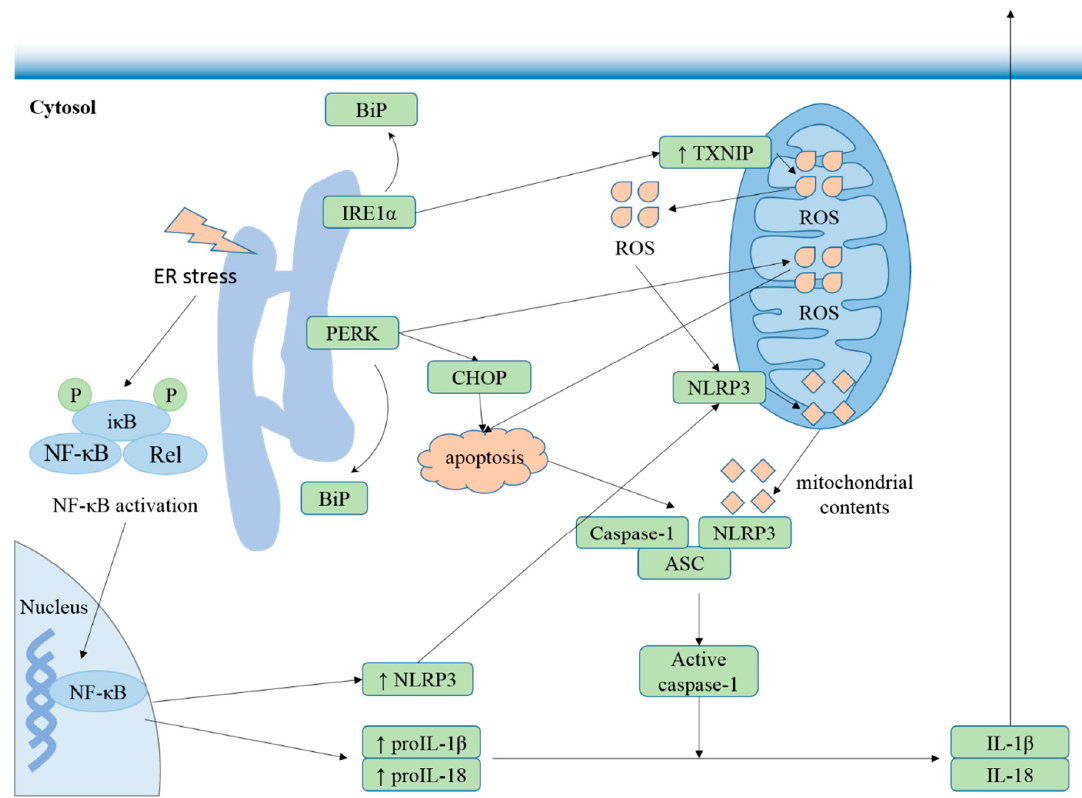
Figure 4. ER stress is involved in NLRP3 inflammasome activation. ER stress promotes expression of IL-1 β and NLRP3 via the NF- κ B pathway, contributing to NLRP3 inflammasome activation [79]. In response to ER stress, IRE1 α reversibly dissociates from the endoplasmic reticulum chaperone immunoglobulin-binding protein (BiP) [80], induces thioredoxin interacting protein (TXNIP) translocation to mitochondria, ROS release, and NLRP3 association with mitochondria, promoting release or externalization of mitochondrial contents, which bind and activate NLRP3, provoking secretion of proinflammatory cytokines such as IL-1 β and IL-18 [73]. Protein kinase-(PKR)-like eukaryotic initiation factor 2 α kinase (PERK) contributes to apoptosis by sustaining the level of C/EBP-homologous protein (CHOP) and facilitating the propagation of ROS signals after dissociation from BiP [81–83], and apoptosis acts as the second signal to activate NLRP3 [7].